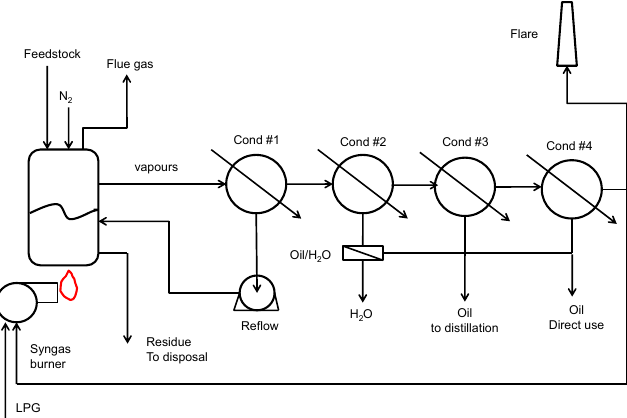
Figure 1. Simplified process flow diagram of the pyrolysis plant. LPG: Liquefied Petroleum Gas.